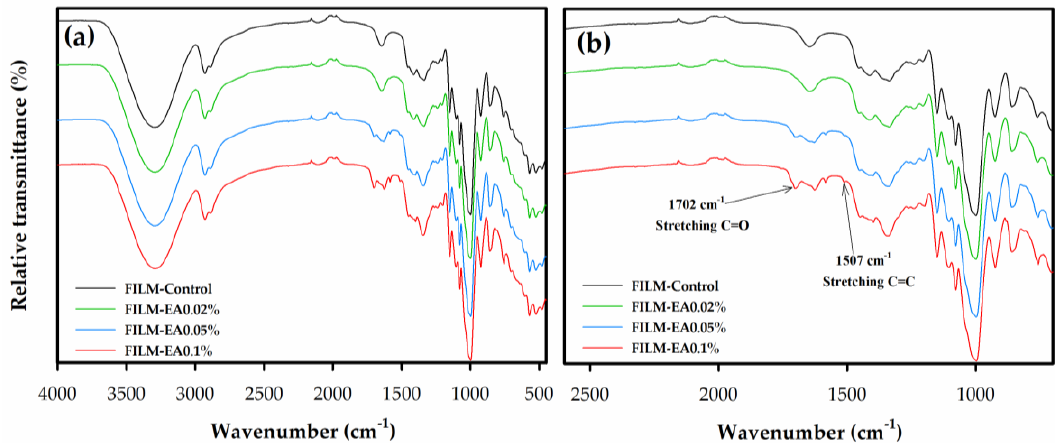
Figure 4. Fourier transform infrared (FTIR) spectra evaluated in: ( a ) 4000–650 cm −1 and ( b ) 2600–700 cm −1 of apple starch films without ellagic acid (FILM-Control) and with ellagic acid (EA) added to 0.02% (FILM-EA0.02%), 0.05% (FILM-EA0.05%) and 0.1% (FILM-EA0.1%).